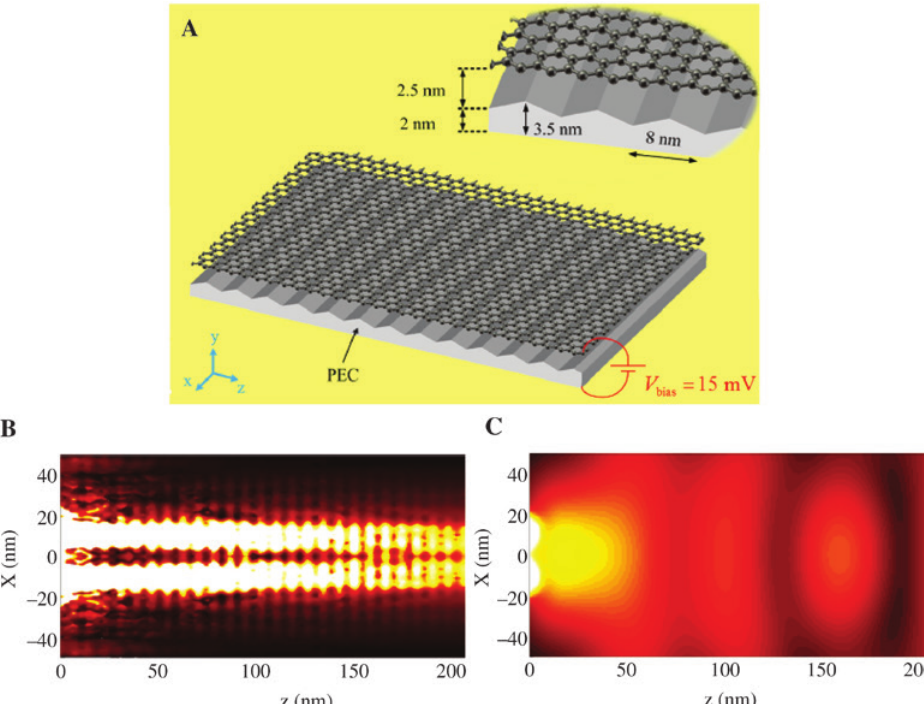
Figure 7: Surface-wave canalization on a modulated-graphene metasurface. (A) A graphene monolayer with fixed gating voltage over a triangularly perturbed ground plane that realizes a tailored conductivity modula- tion. (B and C) Amplitude of the vertical component of the electric field for the surface plasmon polaritons launched by two closely located point sources over (B) modulated graphene and (C) homogeneous graphene. Adapted with permission from Ref.